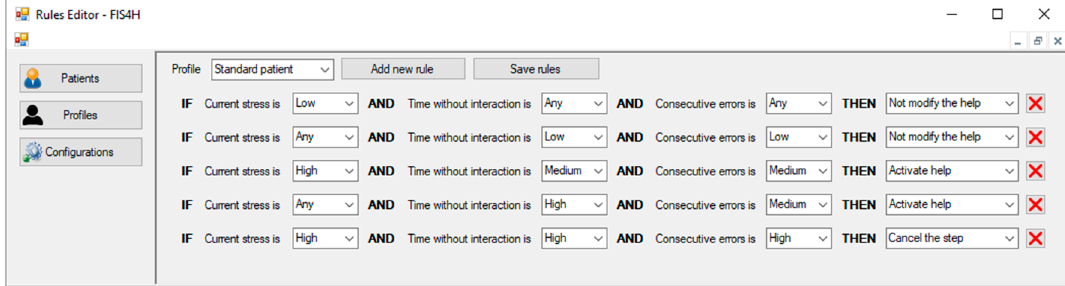
Figure 15. Rules editor interface of the FIS4H.